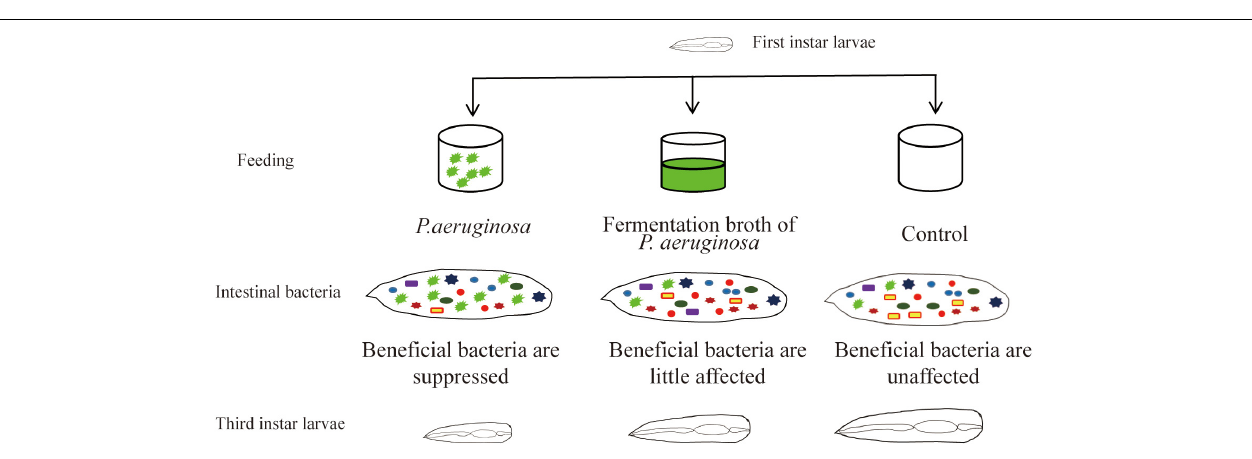
FIGURE 8 | Pattern diagram of the influence P. aeruginosa exhibited on the growth of housefly